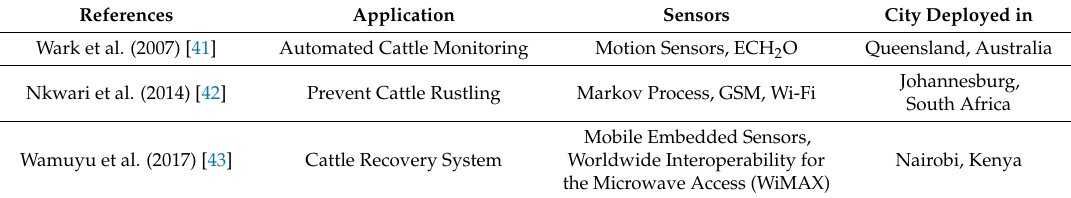
Table 4. Examples of prototyped applications for livestock. WiMAX: Worldwide Interoperability for the Microwave